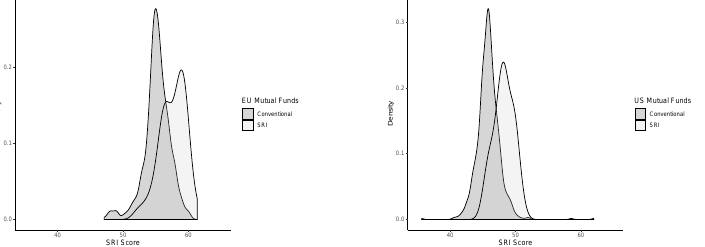
Figure 1. Density functions of mutual funds’ SRI scores: Europe and the United States. Notes : This figure plots the distribution of SRI scores of European and US mutual funds. Scores proxy for de facto SRI. The classification “Conventional”/”SRI” represents de jure SRI. Distributions of the ESG scores from Morningstar and MSCI exhibit the same features (figure available upon request).